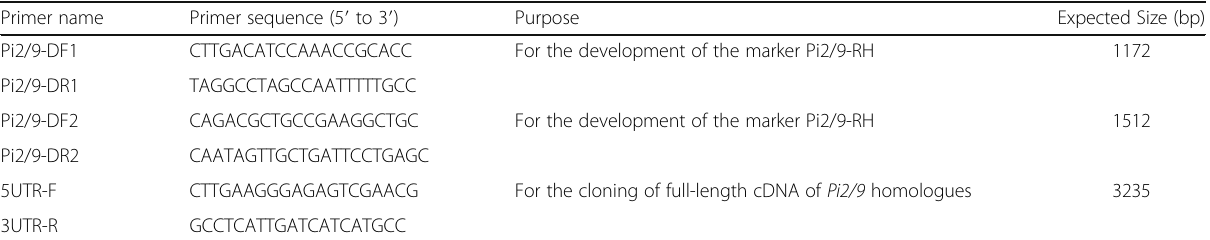
Table 1 Primers used in this study